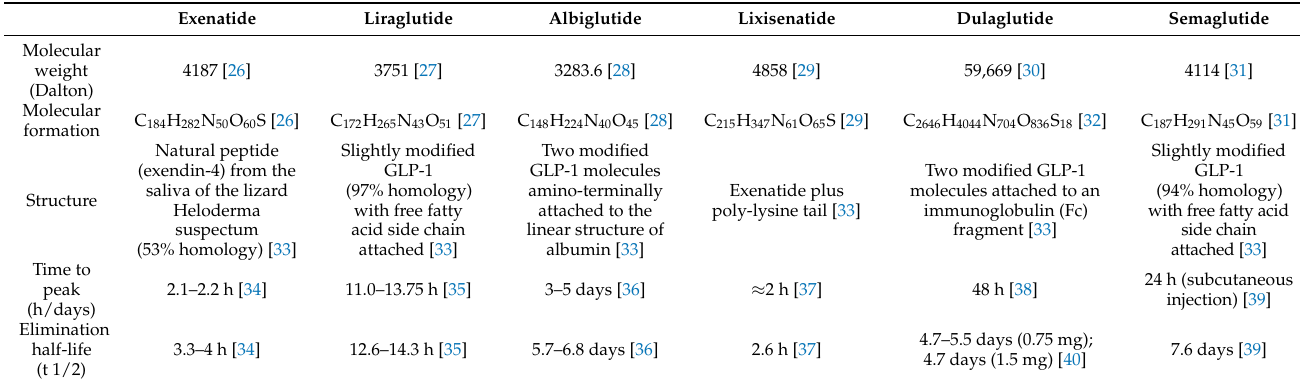
Table 1. Characteristics of GLP-1